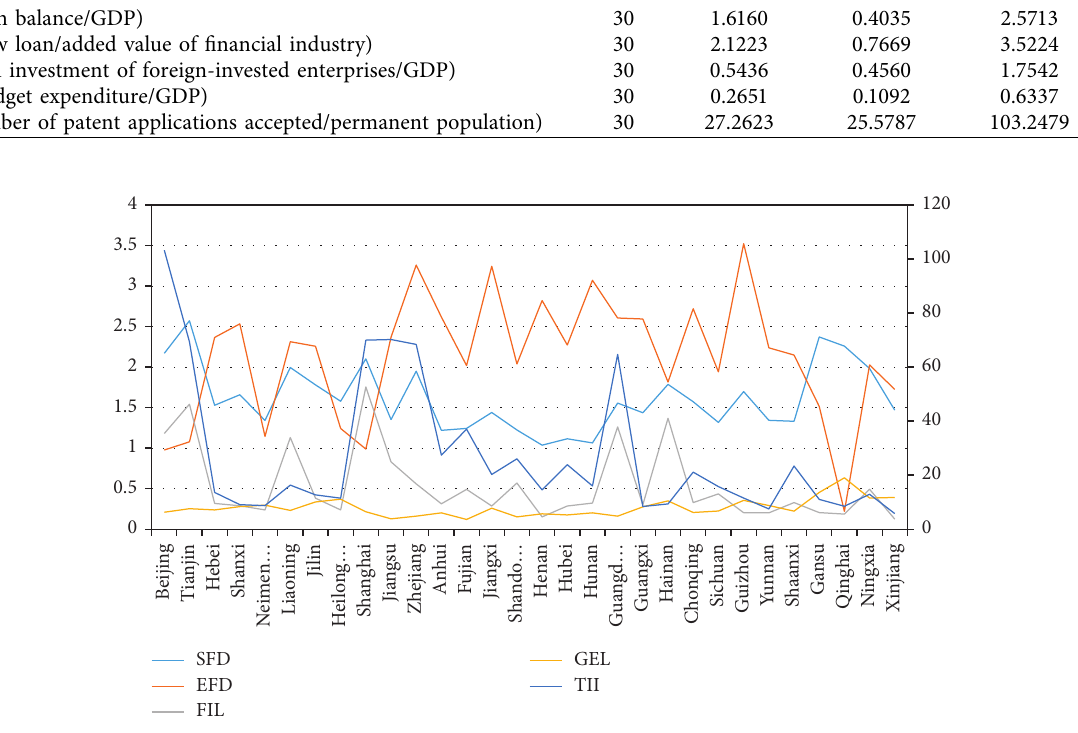
Figure 3: Scatter plot of conditional variables. Note: TII corresponds to the secondary axis.